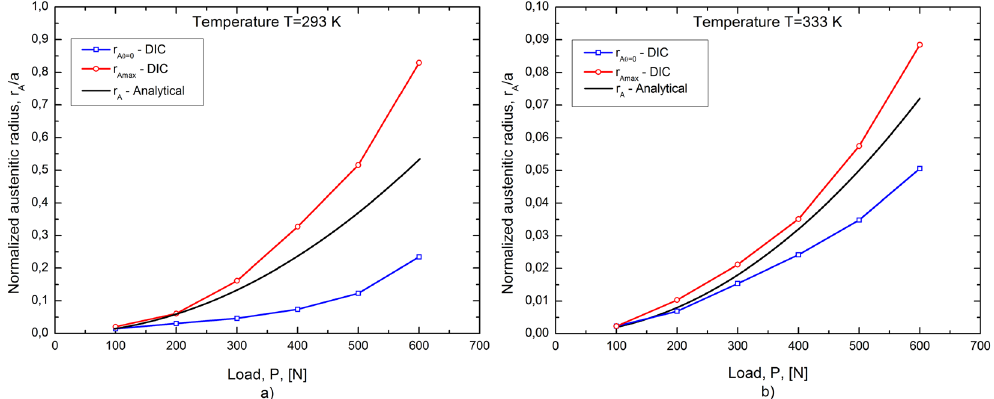
Figure 5. Comparison of the normalized austenitic radius vs load ( r A / a vs P ), between analytical model and DIC results: ( a ) T = 293 K and ( b ) T = 333